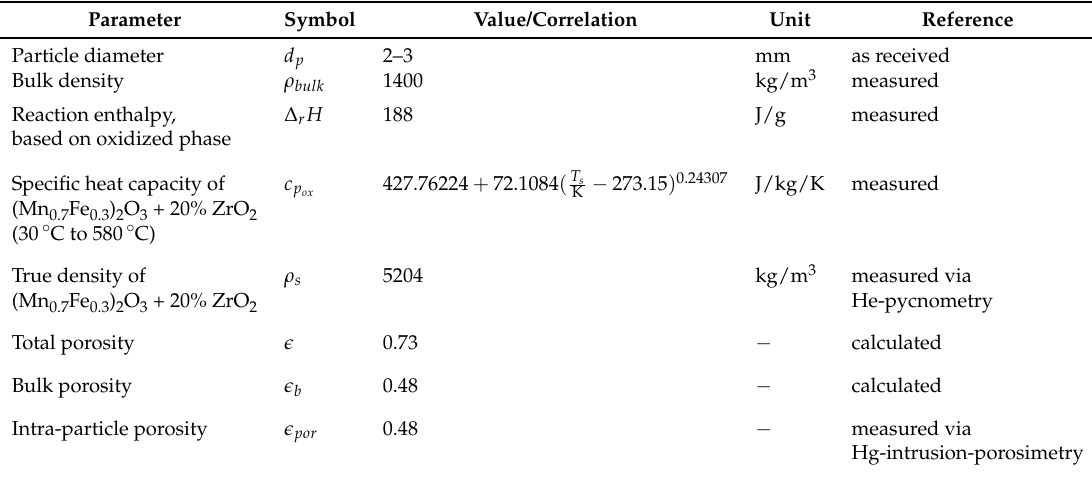
Table 1. Material parameters of the manganese–iron-oxide